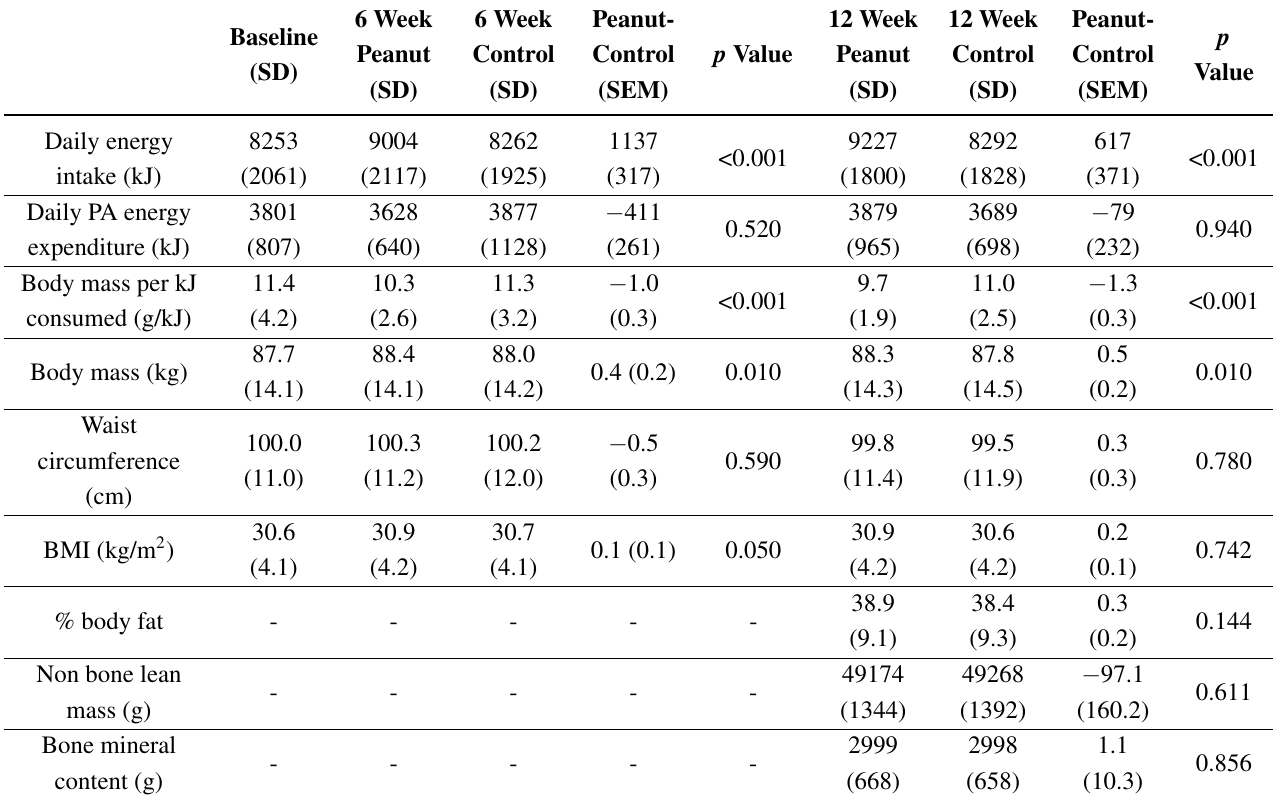
saturated fatty acids; MUFA, monounsaturated fat. Table 3. Effect of 6 and 12 week high oleic peanut consumption and nut free diet on energy intake, physical activity energy expenditure and anthropometric and body composition